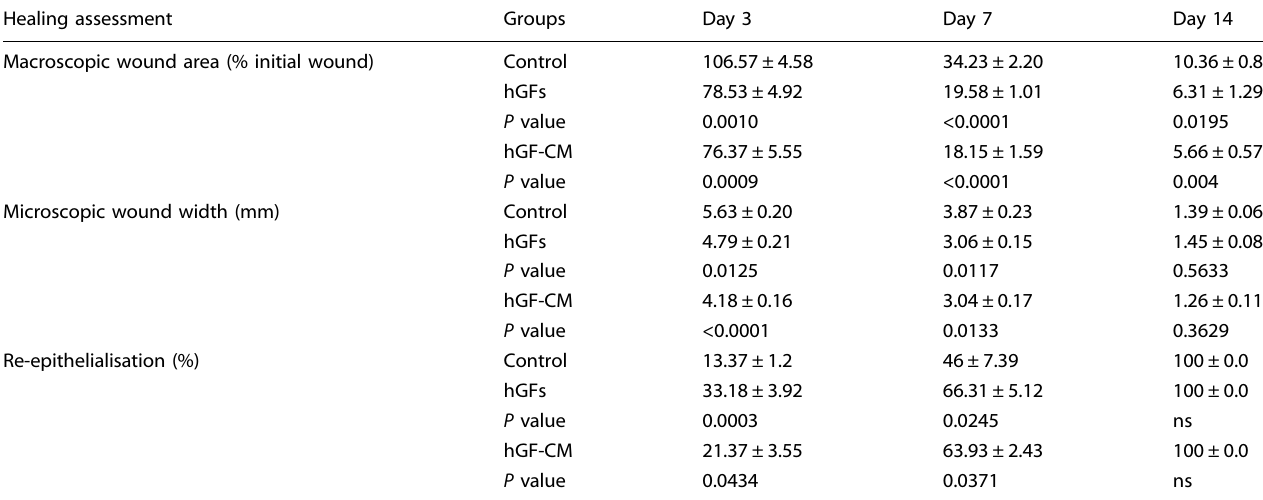
Table 1. Assessment of excisional wound healing in hGFs and hGF-CM treated mice. Healing